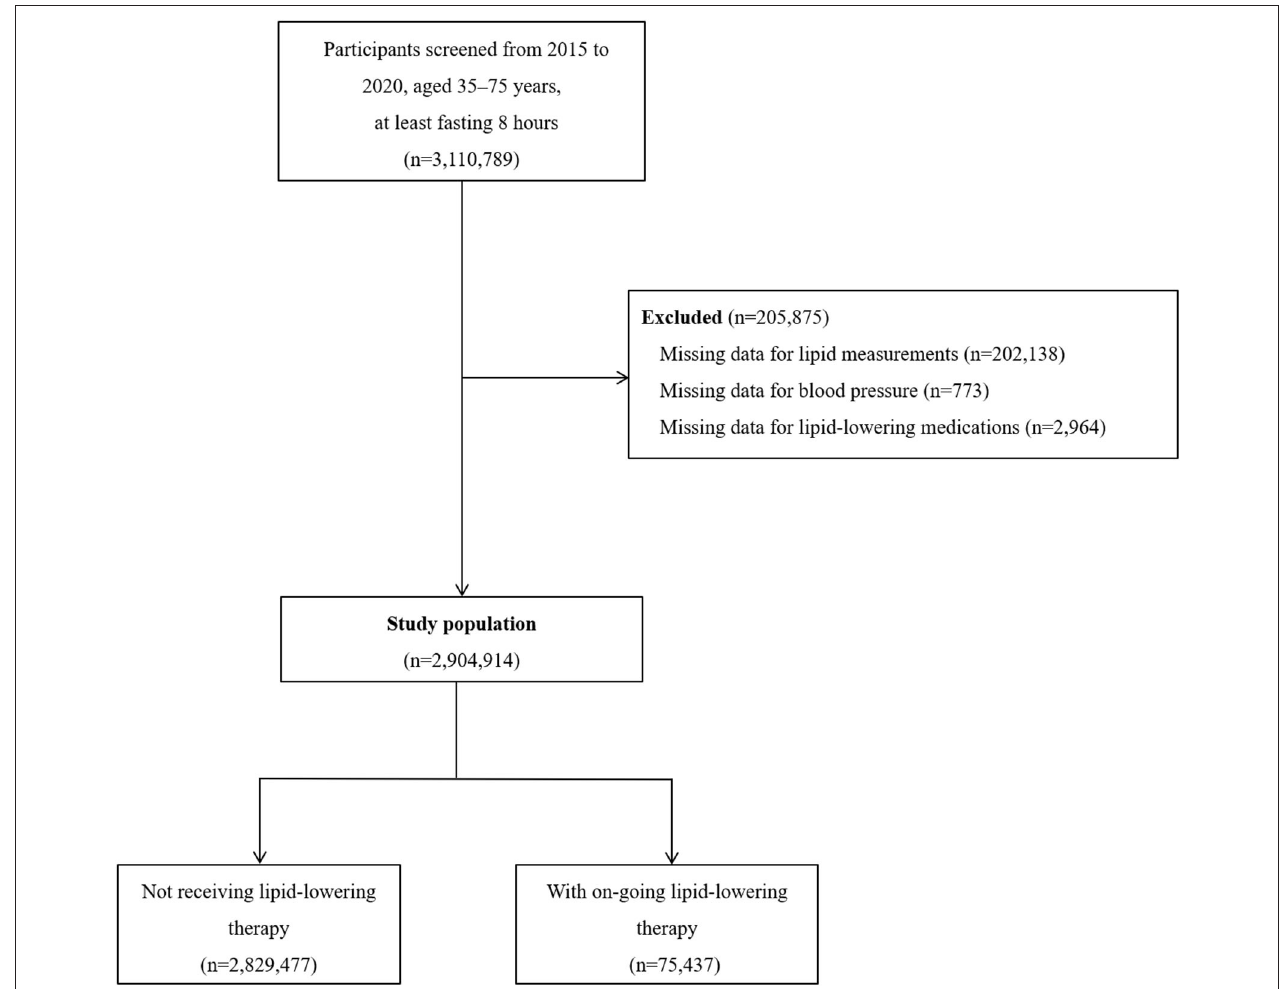
FIGURE 1 | Flowchart for the study